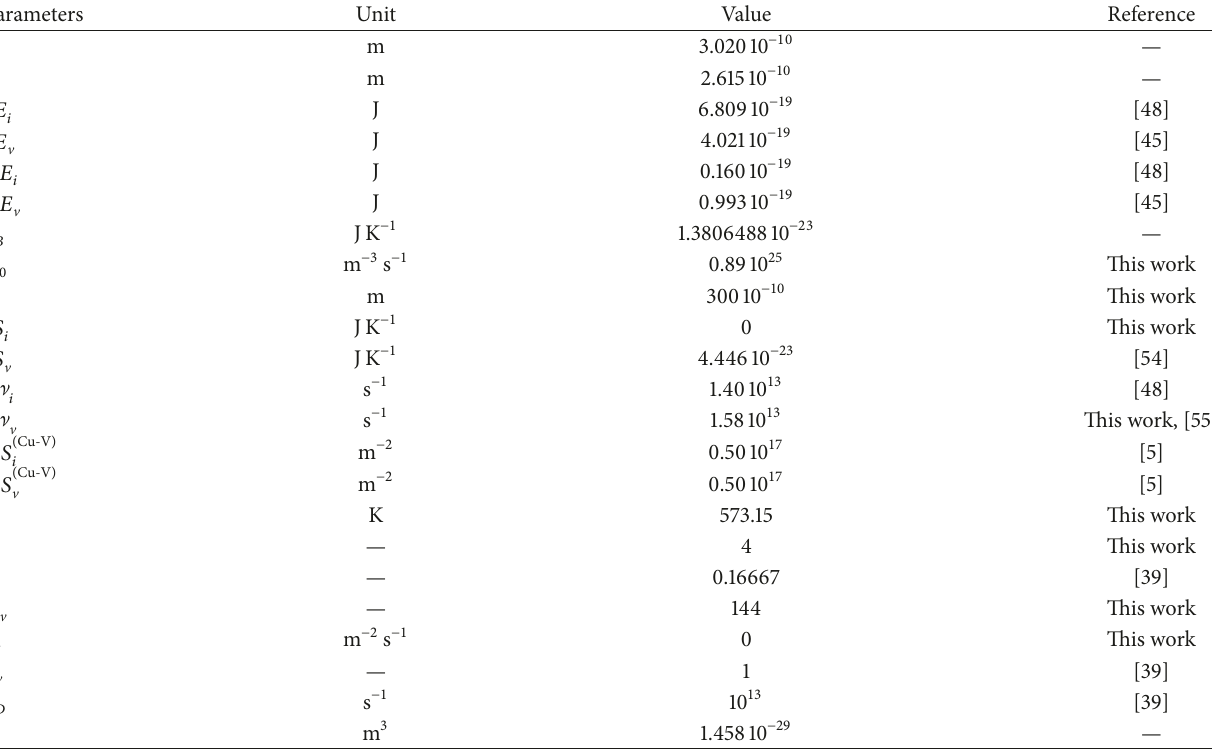
Table 5: Model parameters for